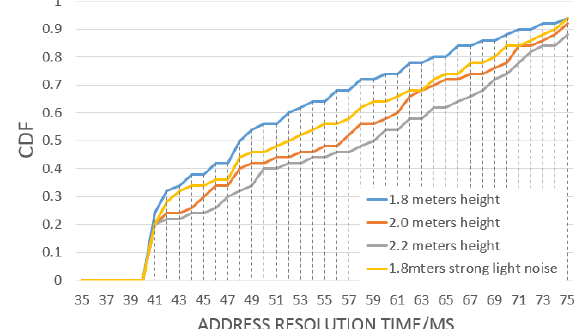
Figure 10. Corner region location time & resolution success rate